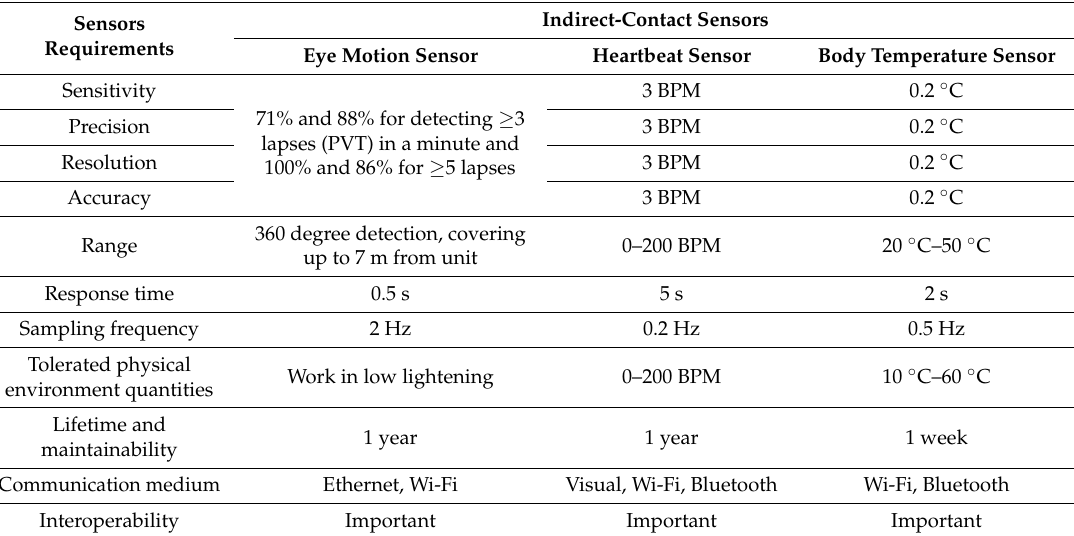
Table 2. High level requirements for indirect-contact sensors.